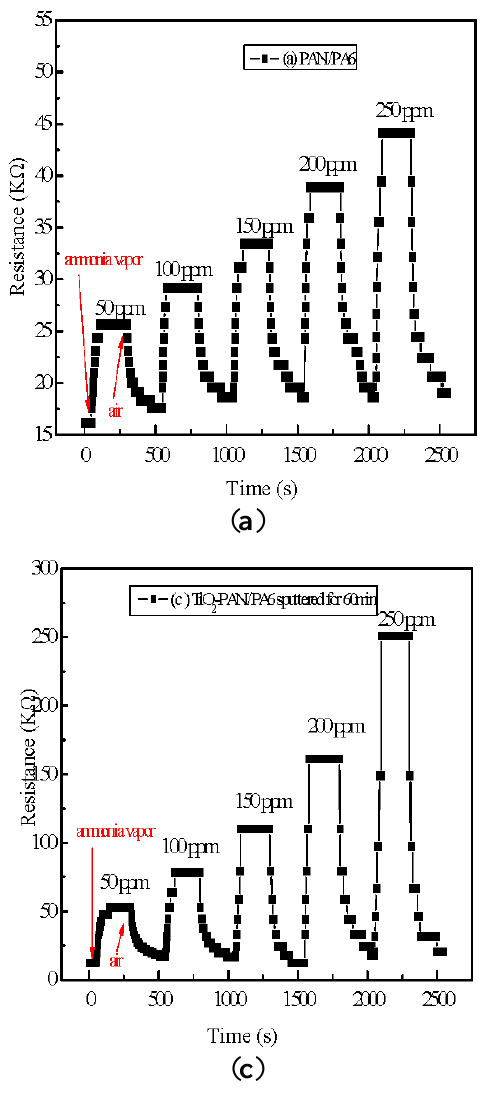
-PANI/PA6 sputtered for 2